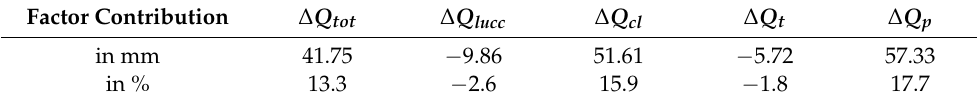
Table 5. Contribution of various factors to runoff changes in the Jinghe River Basin. Factor Contribution ∆ Q